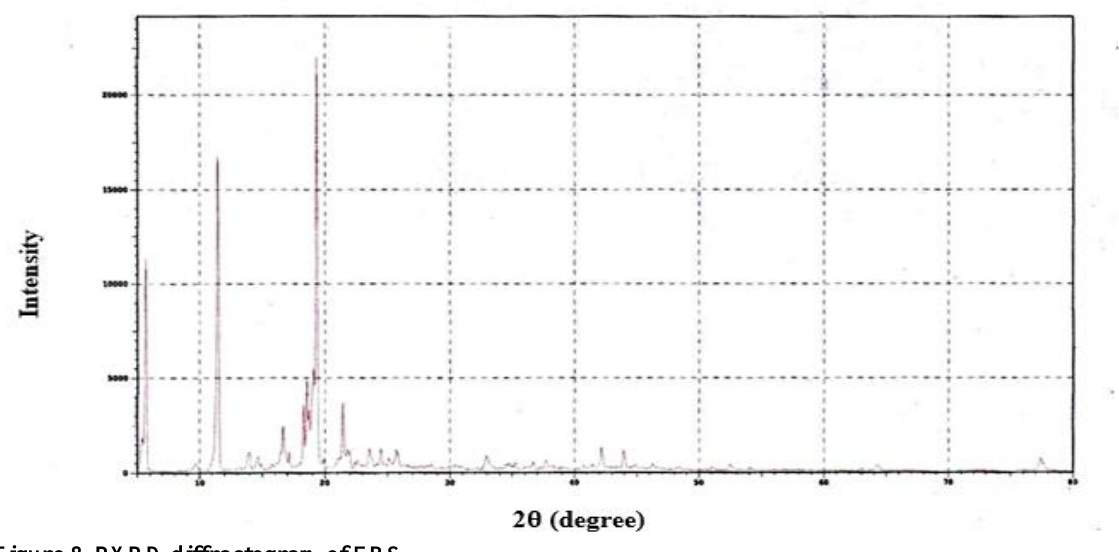
Figure 8. PXRD diffractogram of